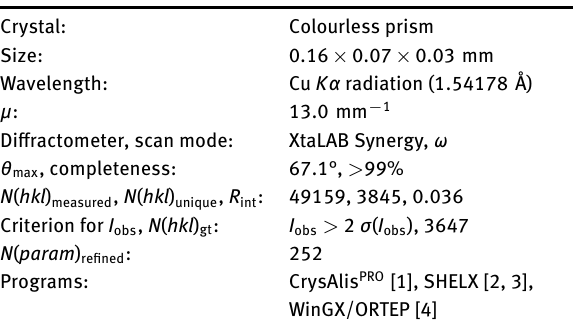
Table 1: Data collection and